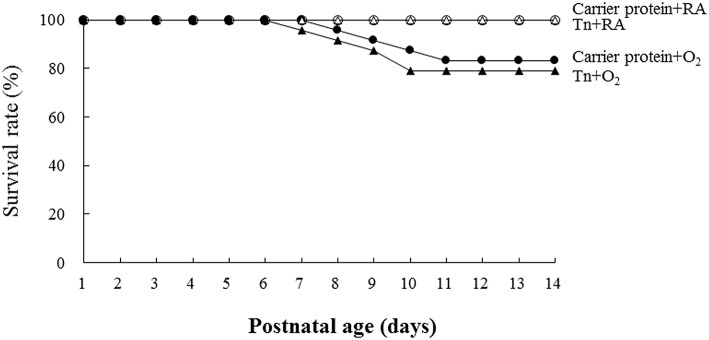
Effects of Tn immunization on the survival rate on postnatal day 14. The rats in the carrier protein + RA or Tn vaccine + RA group all survived. The rats in the carrier protein + O2 or Tn vaccine + O2 group exhibited a lower survival rate after postnatal day 7. On postnatal day 14, the survival rate between the rats treated with carrier protein or Tn immunization were comparable.